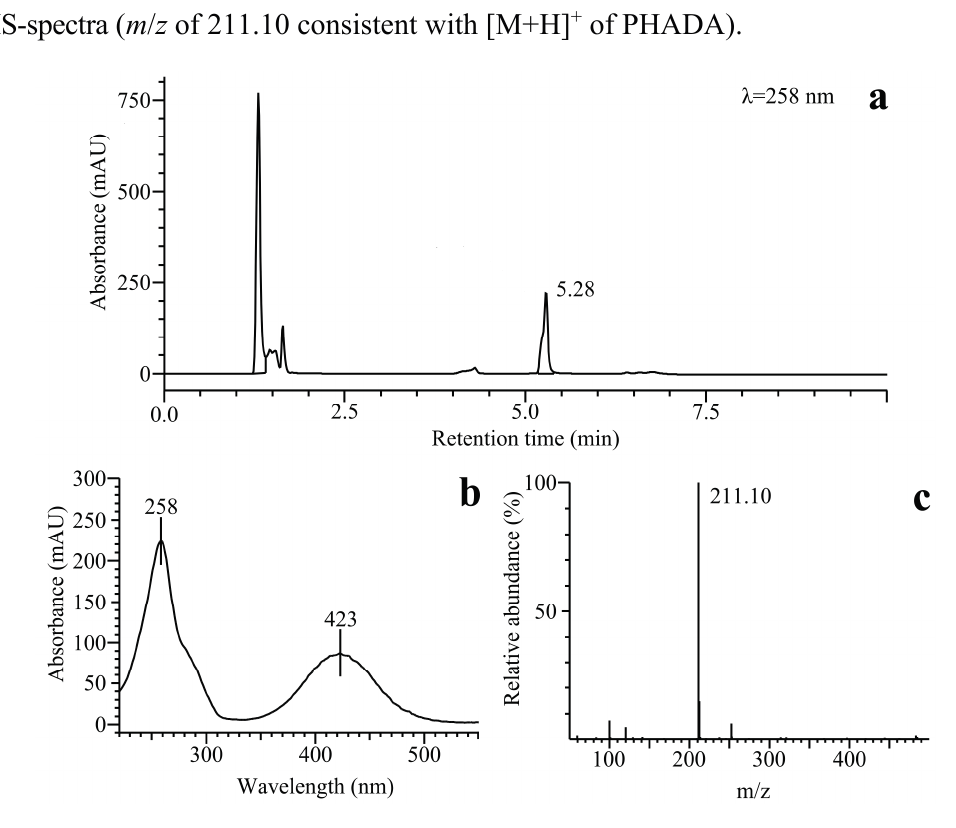
Figure 8 . The liquid chromatography and mass spectrometry (LC-MS) analysis of the NQO1-catalyzed reduction product of benzofuroxan: ( a ) UV chromatogram of the reaction mixture; ( b ) UV-VIS absorbance spectrum of 2,3-diaminophenazine (PHADA);